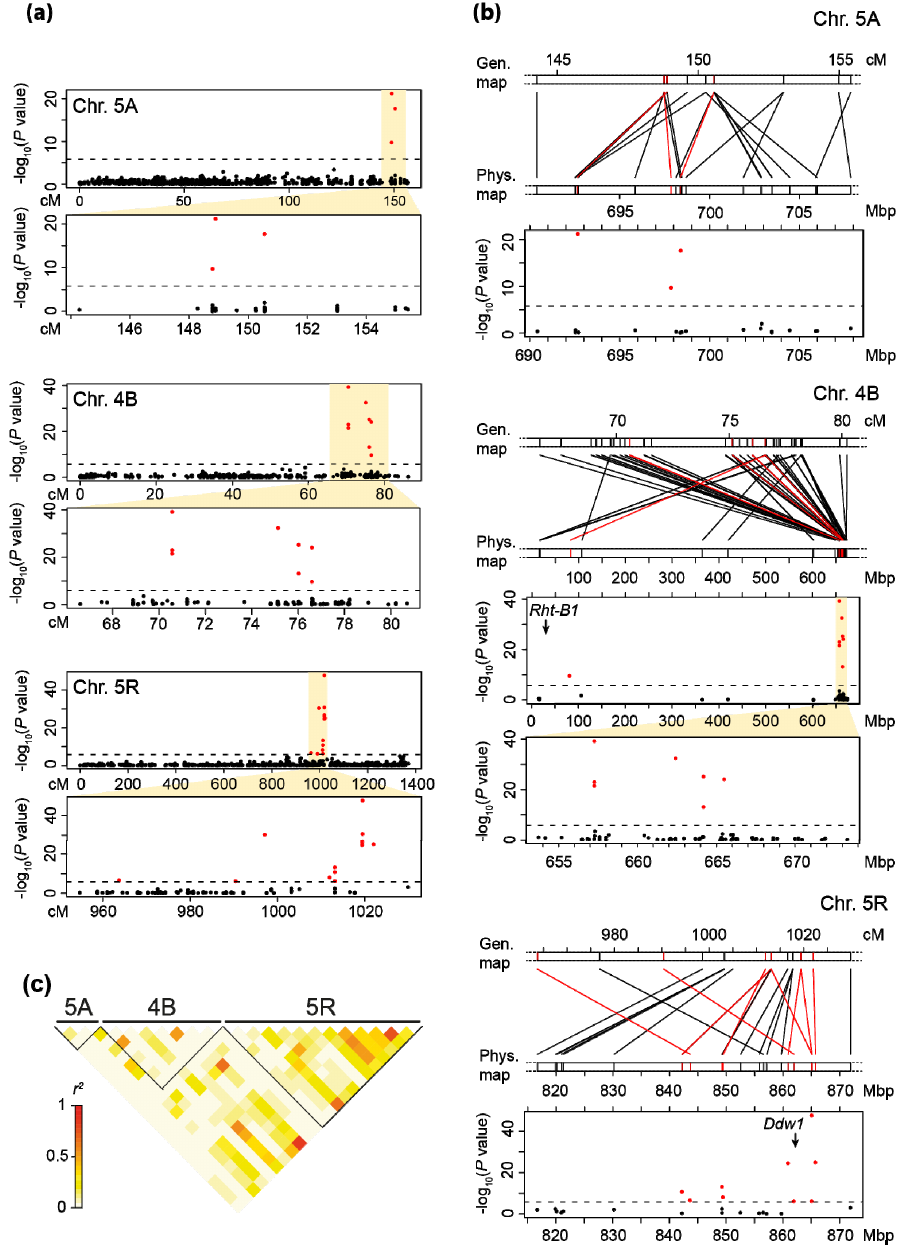
Figure 3. Fine-mapping of the identified QTL. ( a ) Genetic and ( b ) physical fine-mapping of the QTL on chromosomes 5A, 4B, and 5R. Red dots and lines indicate significantly associated markers after a Bonferroni multiple-test correction. ( c ) Linkage disequilibrium ( r 2 ) among the markers from the three QTL regions.